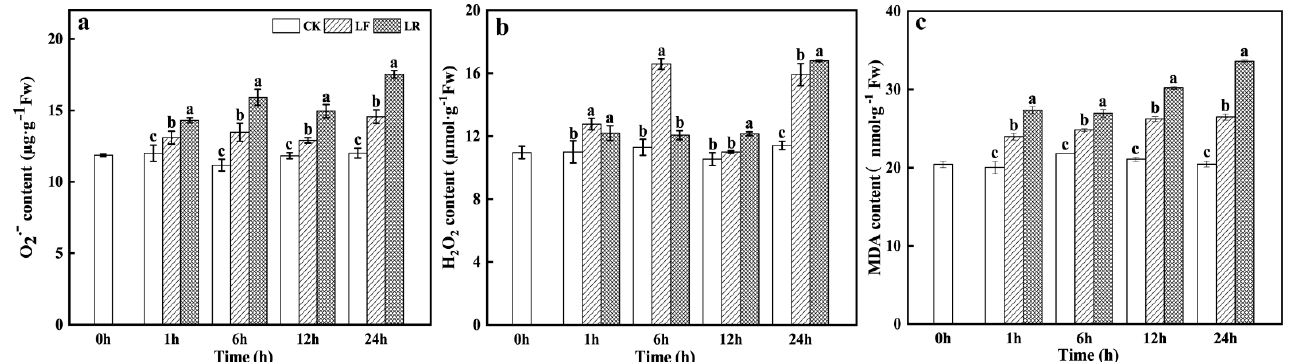
Figure 3. Effect of leaf removal on O 2 − ( a ), H 2 O 2 ( b ), and MDA ( c ) contents in the roots of M. baccata under suboptimal low root–zone temperatures. Means (±SE) of three replicates per treatment at each time point independently. Different lowercase letters on the bars indicate significant differences between treatments.